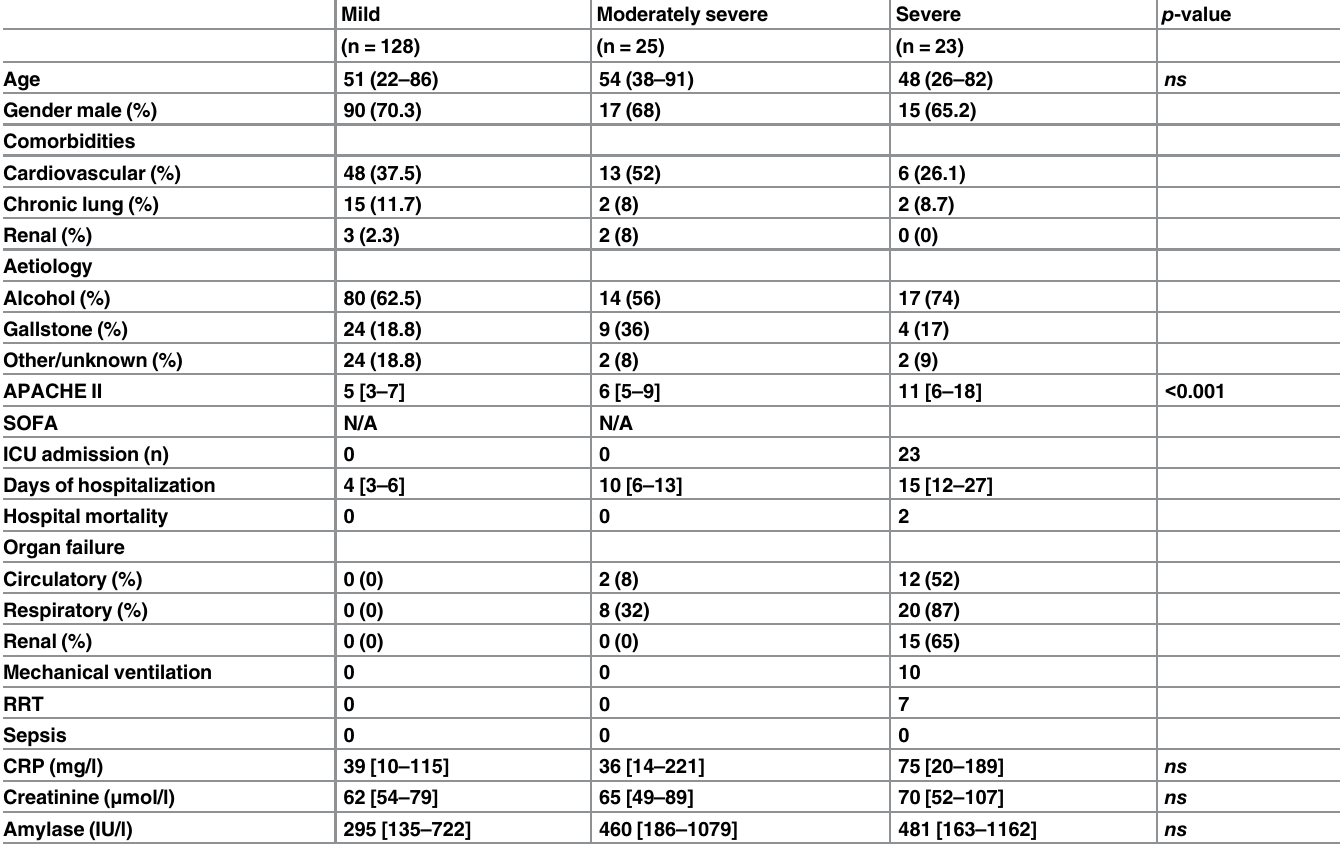
Table 1. Patient demographics and clinical variables.